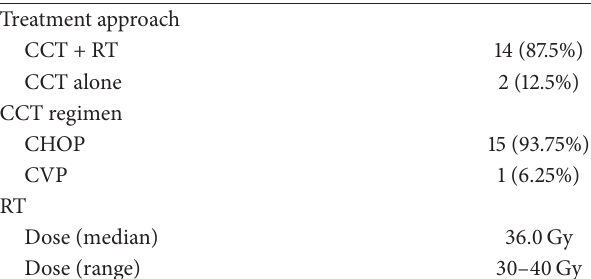
Table 1: Patient characteristics. Table 2: Treatment